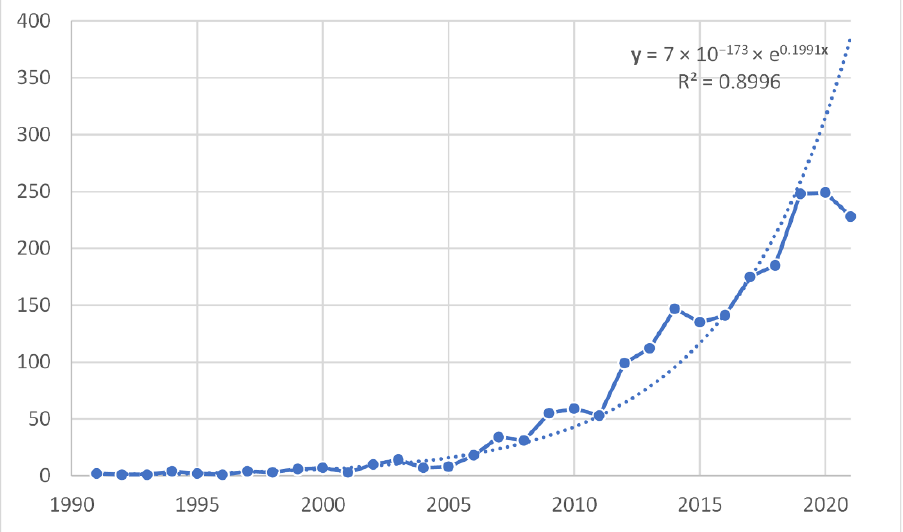
Figure 1. Publication time series and trend on coastal governance.